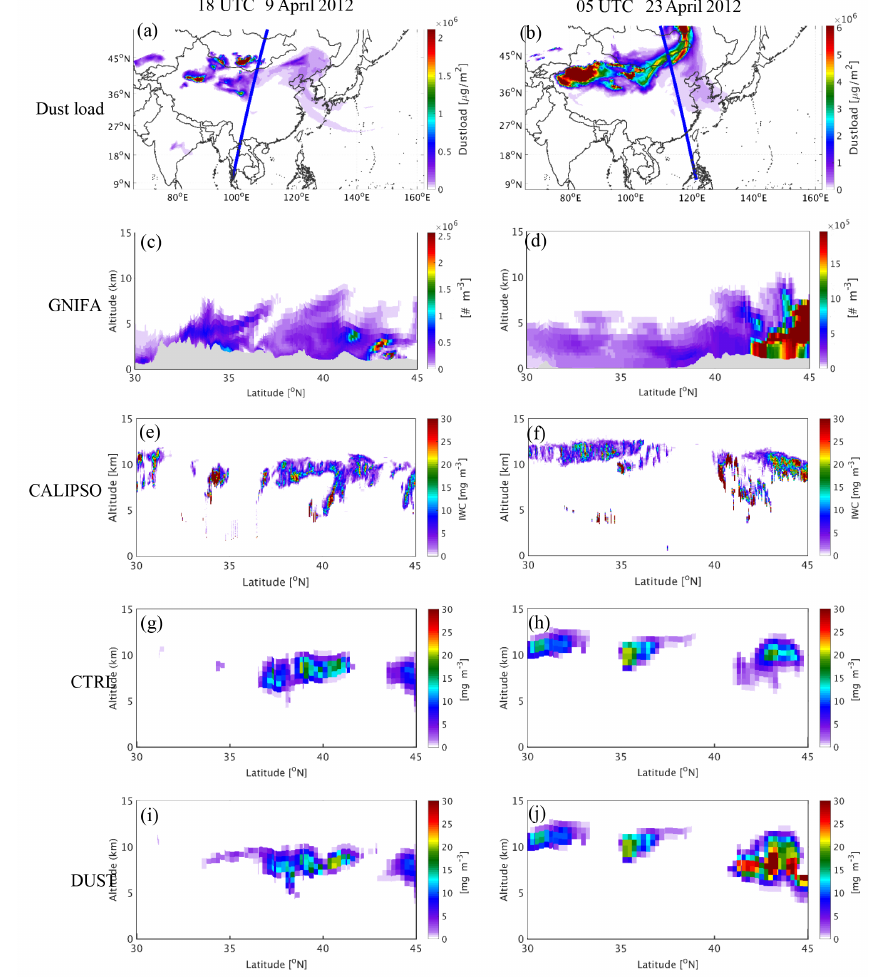
Figure 9. As Fig. 8 but for the cases on 9 April (left column) and 23 April (right column) of 2012.